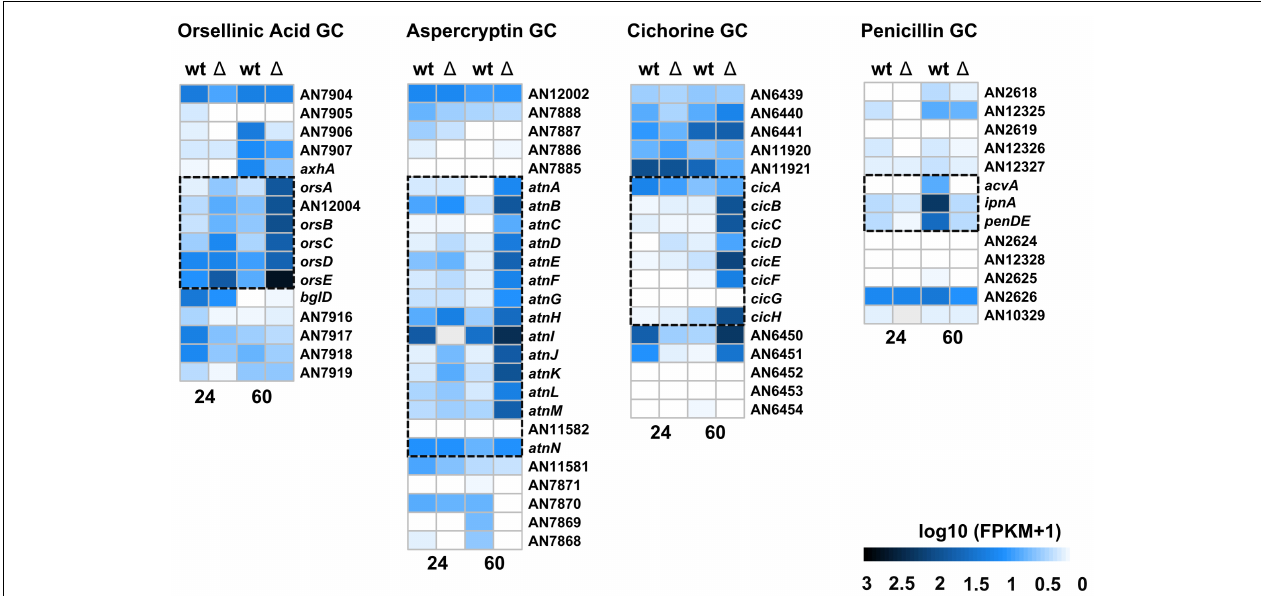
FIGURE 7 | Expression analysis of the most affected biosynthetic clusters in hosA deletion mutants. Heatmaps display expression of the orsellinic acid, aspercryptin, cichorine, and penicillin secondary metabolite gene cluster members and adjacent genes after 24 and 60 h in hosA mutants versus wildtype strains. The predicted genes of each cluster are boxed, FPKM + 1 values are